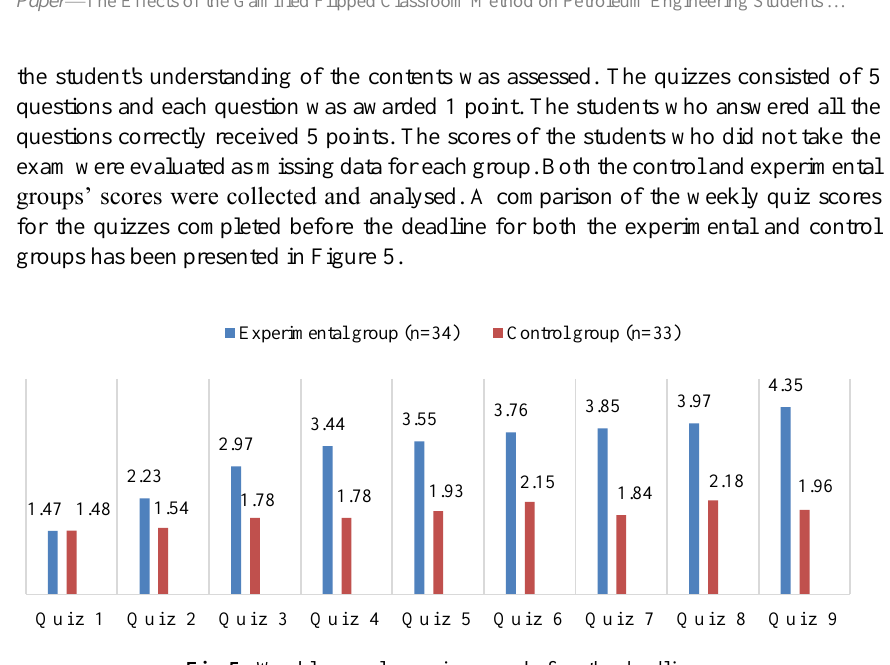
Fig. 5. Weekly pre-class quiz scores before the deadlines.